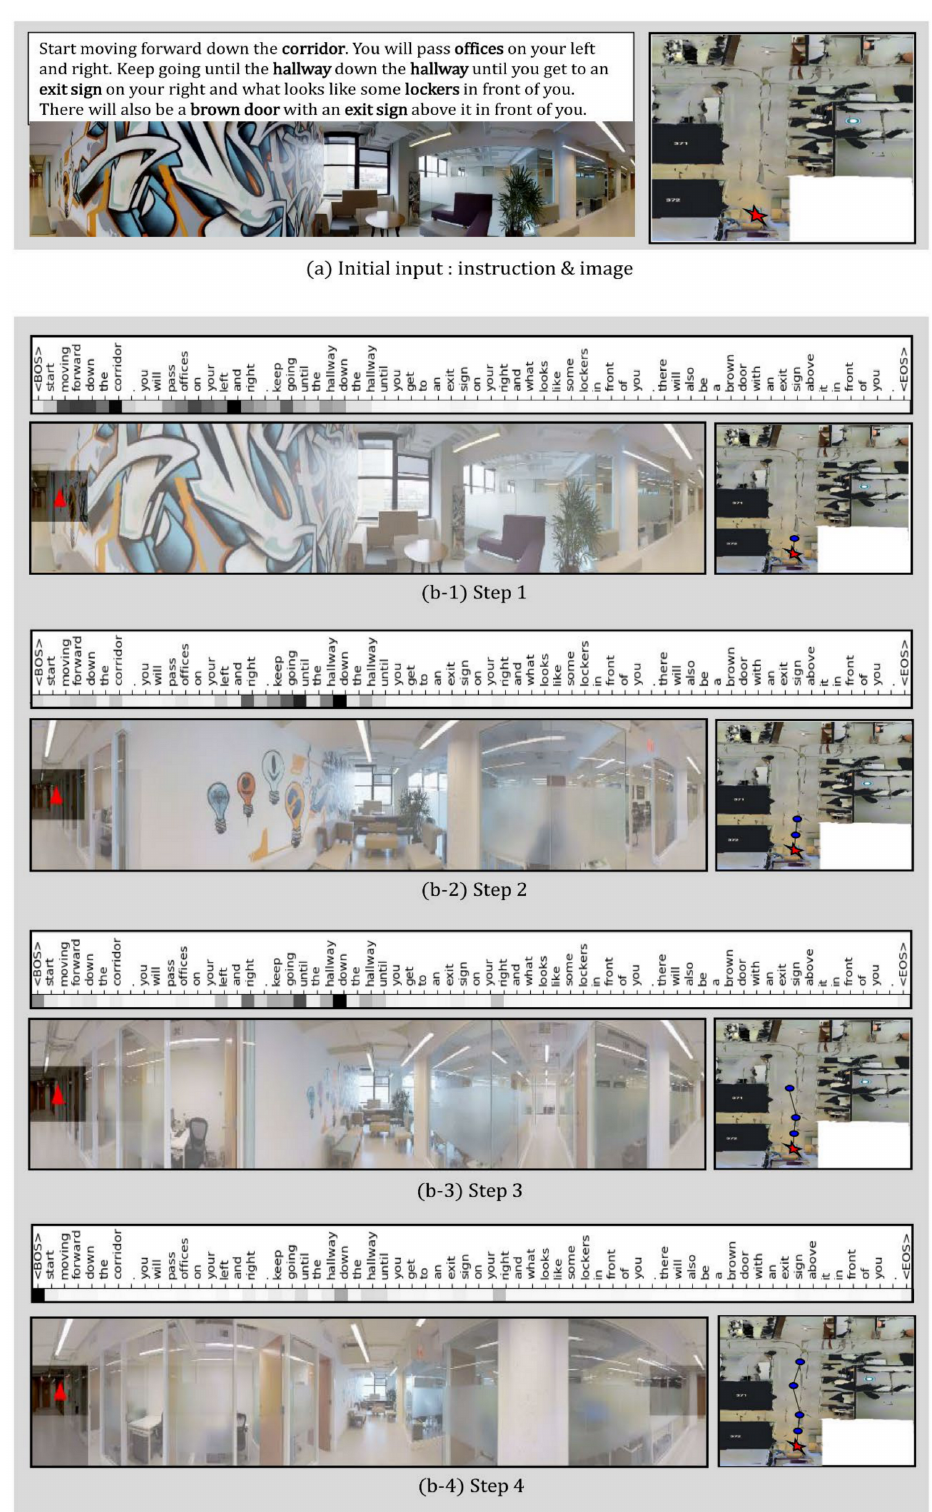
Figure 12. Second example of VLN task executed by the proposed model JMEBS: